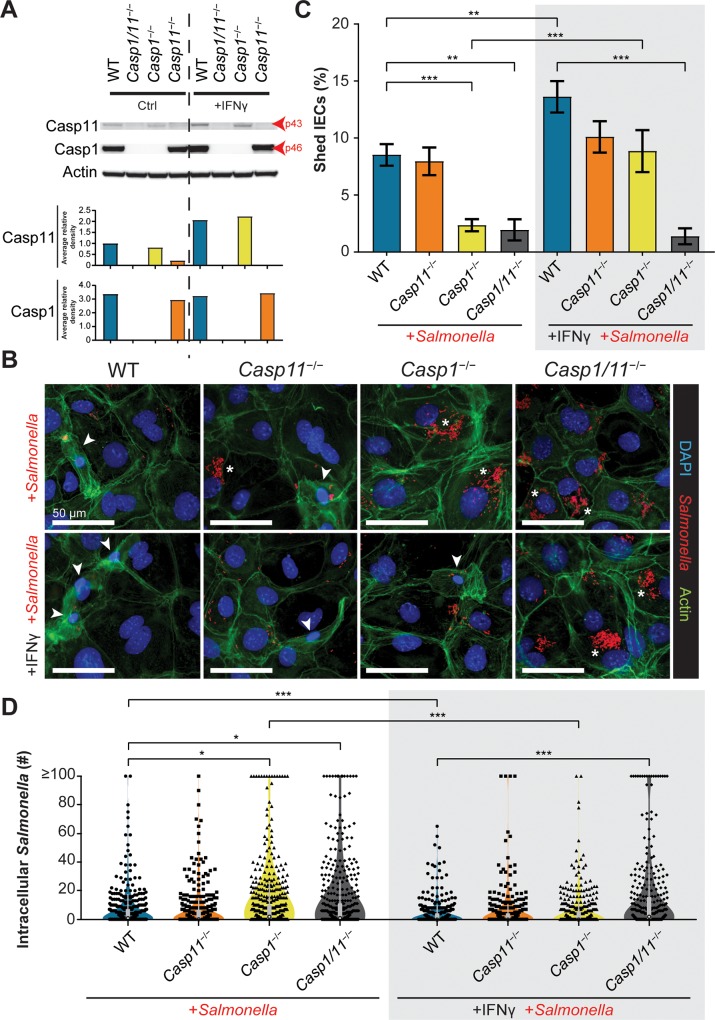
IFN-γ pretreated enteroid monolayers display enhanced levels of IEC shedding and a dependence on caspase-1 and caspase-11 for restriction of Salmonella infection.Enteroids generated from WT, Casp11−/−, Casp1−/− and Casp1/11−/− mice were treated for 16 h with vehicle control or IFN-γ (10 ng/mL), then cell lysates probed for pro-caspase-1 (p46), pro-caspase-11 (p43) or actin by Western blotting. Densities relative to actin are shown (A). Data from a representative experiment is presented. Three independent experiments gave similar results. Cecal enteroid monolayers from WT, Casp11−/−, Casp1−/− and Casp1/11−/− mice were either pretreated with IFN-γ (10 ng/mL) or vehicle control 16 h prior to infection with mCherry-S. Typhimurium (MOI of 50). Representative fluorescence images depicting Salmonella (red), actin (green) and DNA (blue) of cecal enteroid monolayers at 10 h p.i. either with IFN-γ or vehicle control pretreatment (B). Original magnification ×400; scale bars 50μm. Arrows denote actively shedding or shed IECs and asterisks denote large foci of intracellular Salmonella. Percentage of shed/shedding IECs (from five blinded fields of view from two independent experiments) (C). The number of intracellular Salmonella in each infected IEC either primed with IFN-γ or vehicle control (D). Results are from 400 IECs from two independent experiments. Statistical significance for 4C and 4D calculated using Mann-Whitney U-test (*p<0.05; **p<0.01; ***p<0.001).